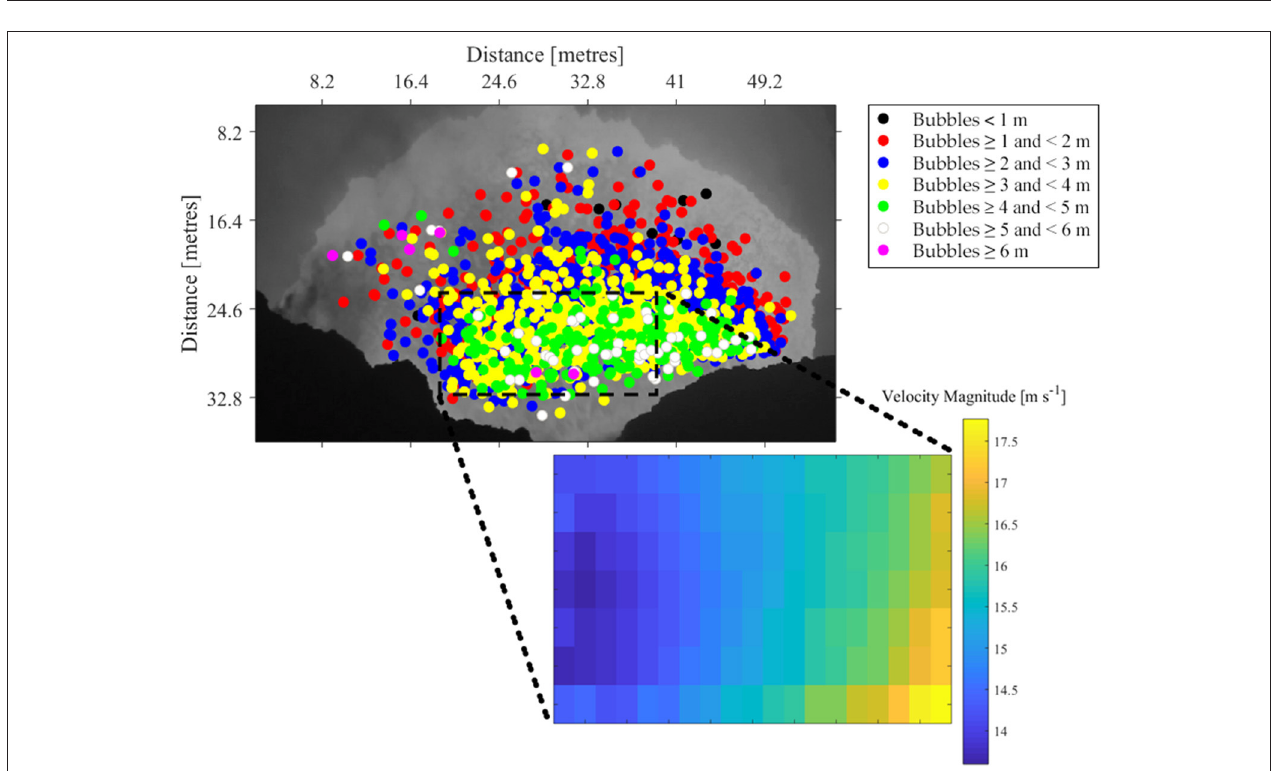
FIGURE 4 | Monochrome image of the lava lake with bubble burst positions indicated, highlighting the general trend that as bubbles get larger their median “Y-axis” position moves closer to the point at which the lavas arrive at the lake surface. Dashed rectangle indicates the region of interest used to calculate averaged pixel area